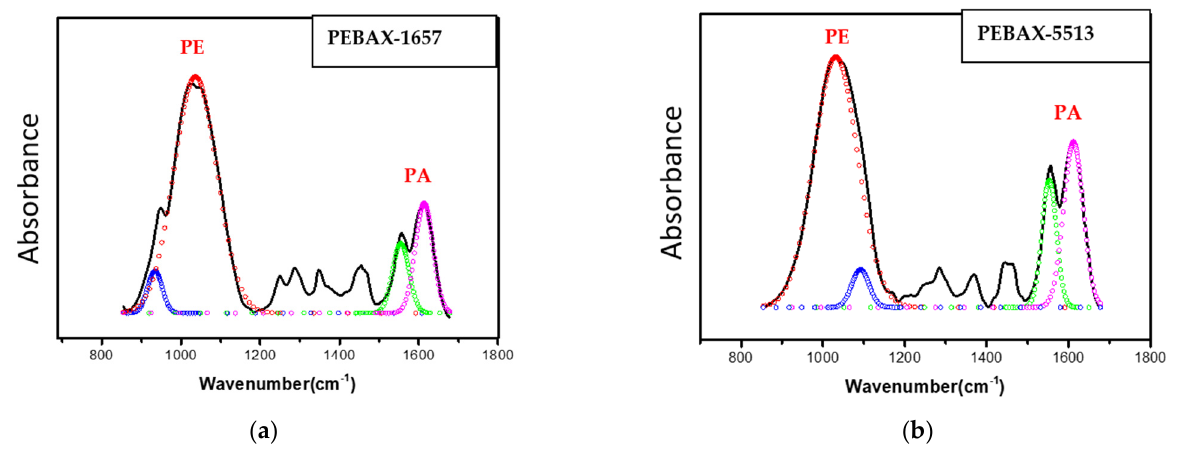
Figure 5. Deconvoluted FT-IR spectra of ( a ) PEBAX-1657 and ( b ) PEBAX-5513. Table 1. Area percentage of each FT-IR peak in PEBAX-1657 and PEBAX-5513 composites. Ether Groups (Area %) Carbonyl Groups (Area %) PEBAX-1657 77.7 22.3 PEBAX-5513 69.7 30.3